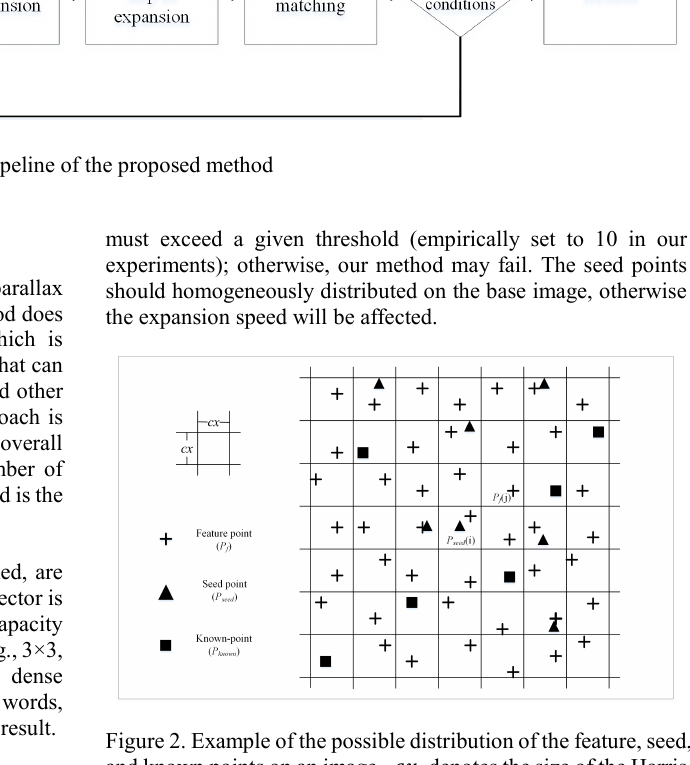
Figure 2. Example of the possible distribution of the feature,